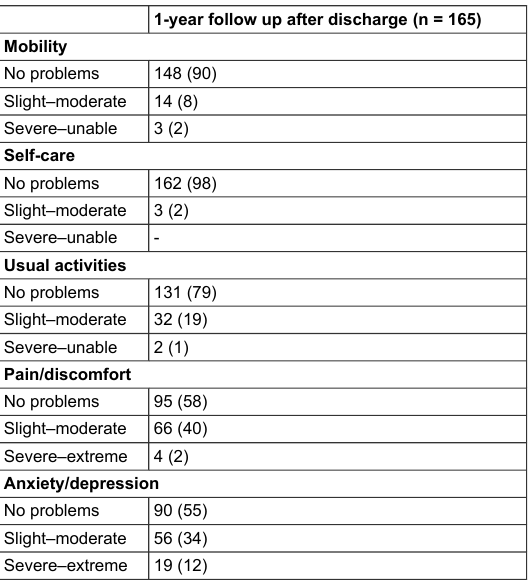
Table 3: Quality of life assessment (EQ-5D-5L) at 1-year follow